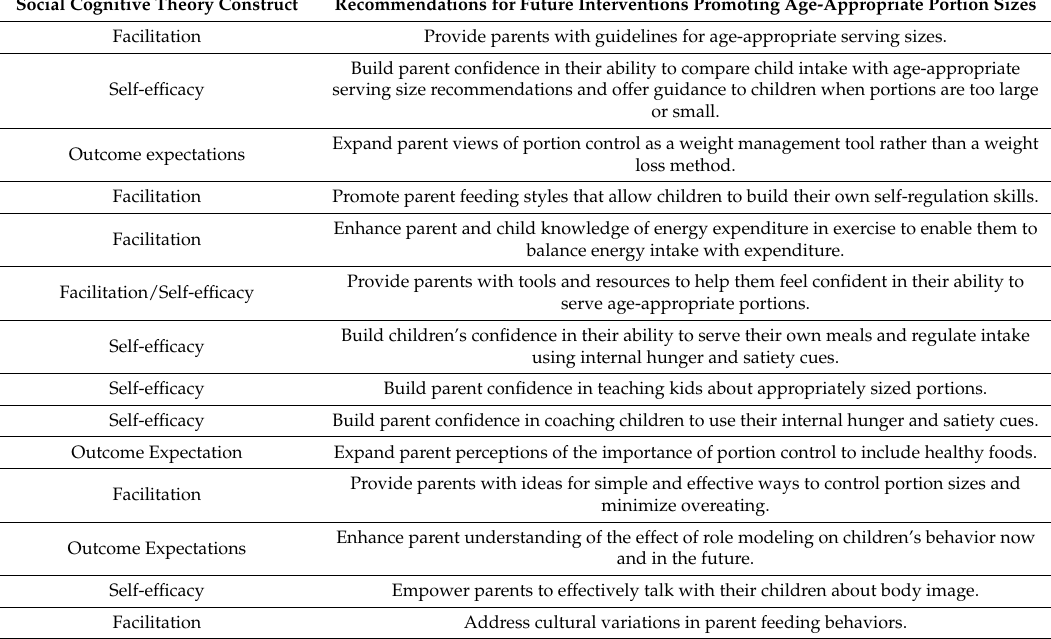
Table 1. Recommendations for Interventions Promoting Age-Appropriate Portion Sizes in Families with School-Age